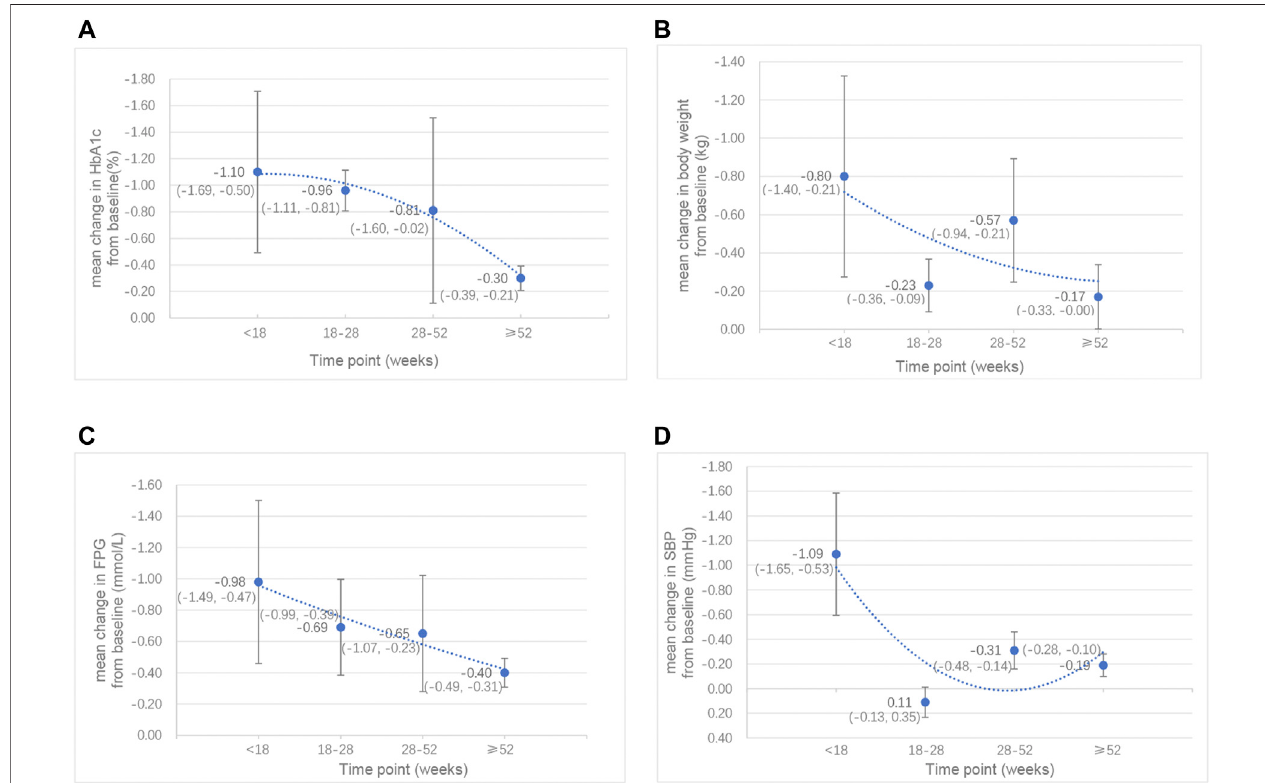
FIGURE 2 | Line chart of the mean changes in (A) HbA1c (%), (B) body weight (kg), (C) FPG (mmol/L) and (D) SBP (mmHg) between the combination therapy of GLP-1RA and SGLT-2i and their monotherapy by week. *Data are presented as mean (95% CI).